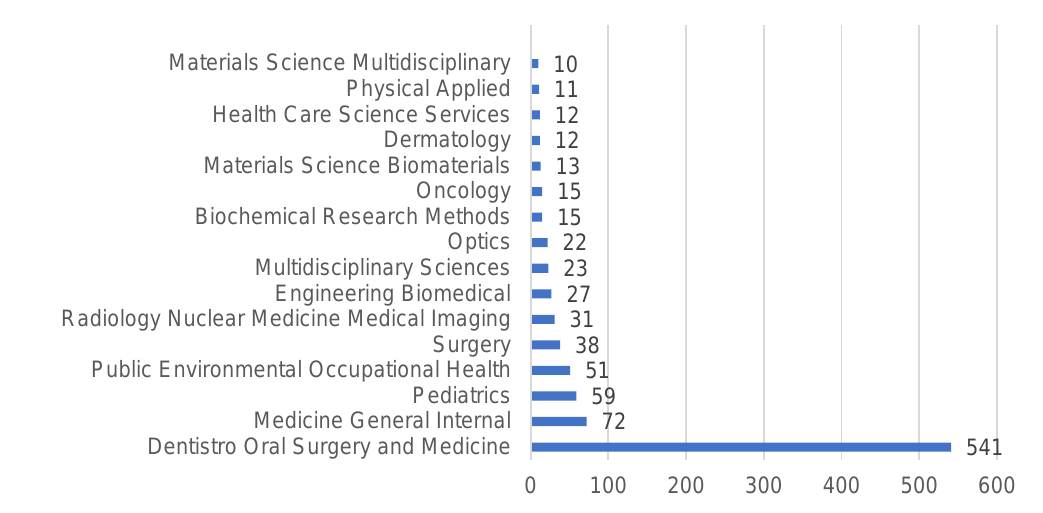
Figure 3. Research areas of the journals with the largest number of publications on the subject under study. The vertical axis shows the categories, while the horizontal axis shows the number of publi- cations.